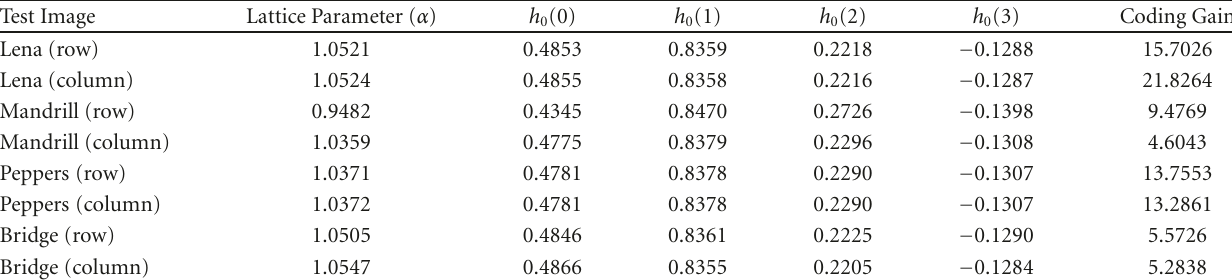
Table 3: Lattice parameters at the maximum coding gains and the corresponding low-pass filter coe ffi cients.